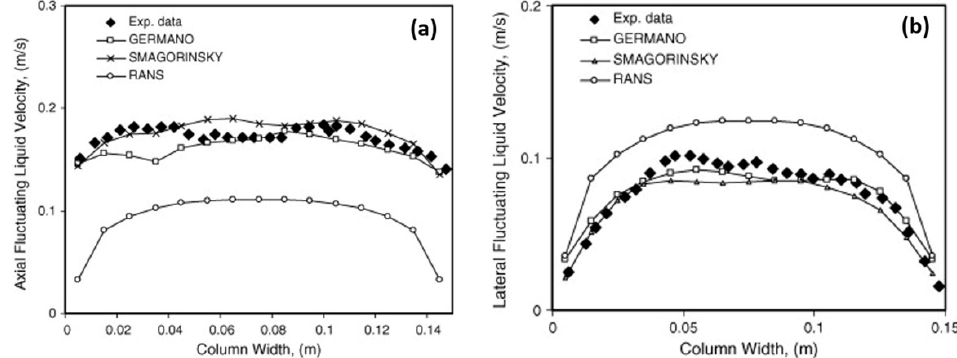
Figure 2. Comparison of model predictions with experimental data for ( a ) axial and ( b ) lateral liquid velocity fluctuations at a height of 0.25 m in a square cross-sectioned bubble column with a superficial gas velocity of 4.9 × 10 − 3 m/s [129].